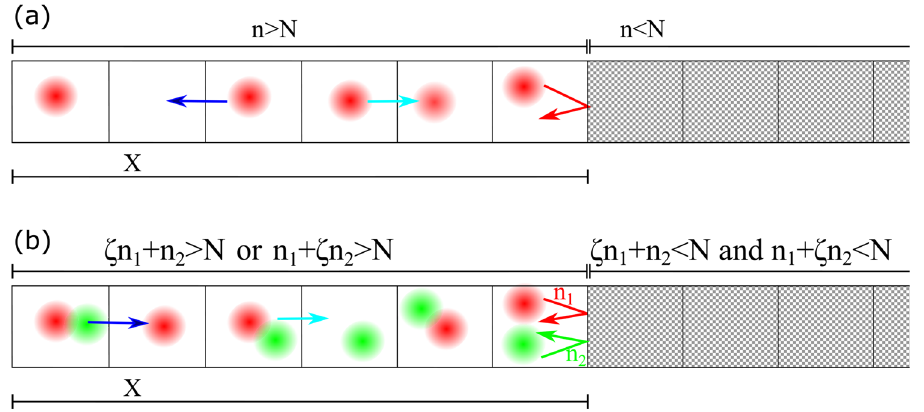
Figure 1. ( a ) Schematic illustration of the single-species model in one dimension. A unit randomly will be selected and duplication and migration trial happen independently. If the selected unit contains a species and two nearest neighbors are empty, the species duplicates into one and can migrate to the other one. The blue arrow shows the direction of upcoming migration to an empty nearest neighbor and the cyan arrow shows upcoming duplication into an empty nearest neighbor. The red arrow shows a failed trial to occupy an empty nearest neighbor. While this attempt has failed, the strength of the barrier has decreased by 1. In a simple single- N trials, the unit becomes occupiable. ( b ) Schematic illustration of the two-species species model, after n = model in one dimension. In a randomly selected unit, each species tries to occupy an empty nearest neighbor. ζ n 2 > N for a unit to become occupiable. Migration and duplication n 2 > N or n 1 We should have ζ n 1 + + happen similar to the single-species model. If the selected unit contains both species, one will be selected randomly for duplication (migration) first and then the other will be selected. However, since we do not include spatial exclusion, selection does not have a relevant role in the majority of